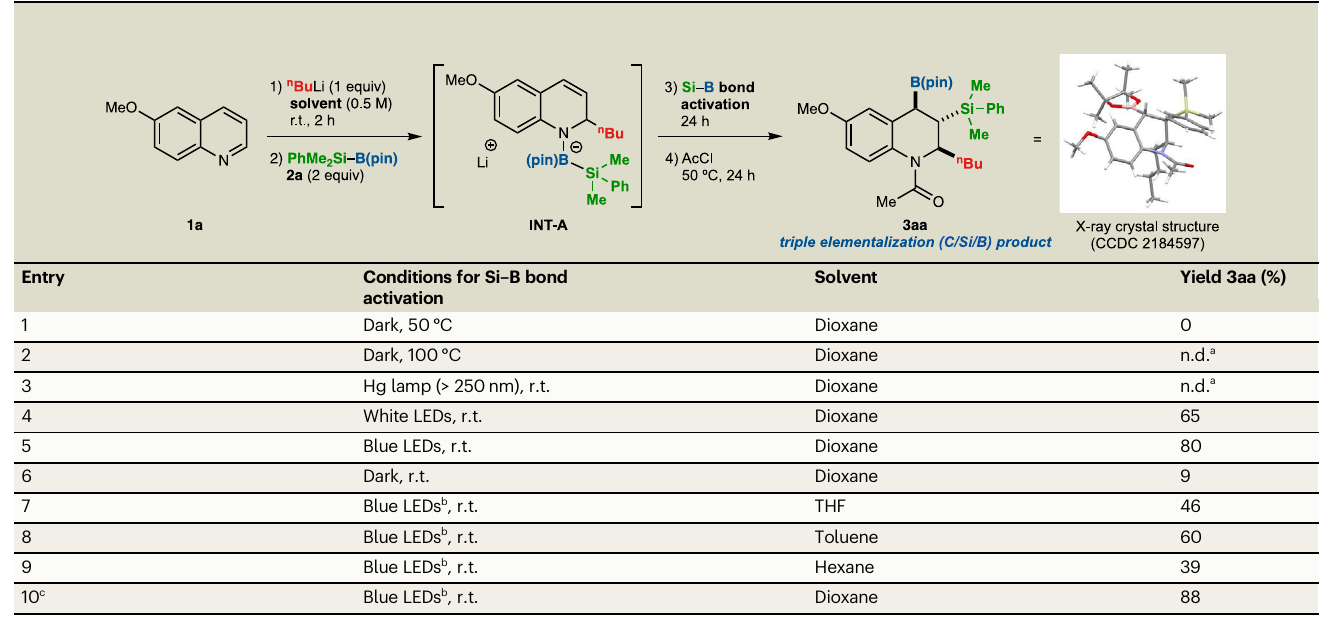
Table 1 | Optimization of reaction conditions